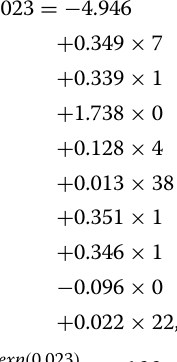
Legend: CI confidence interval, OR odds ratio. Feeling of stress at home ranges from 1 (no stress) to 10 (maximum stress) and responsibility for childcare/family member ranges from 1 (no responsibility/not applicable) to 6 (full responsibility)